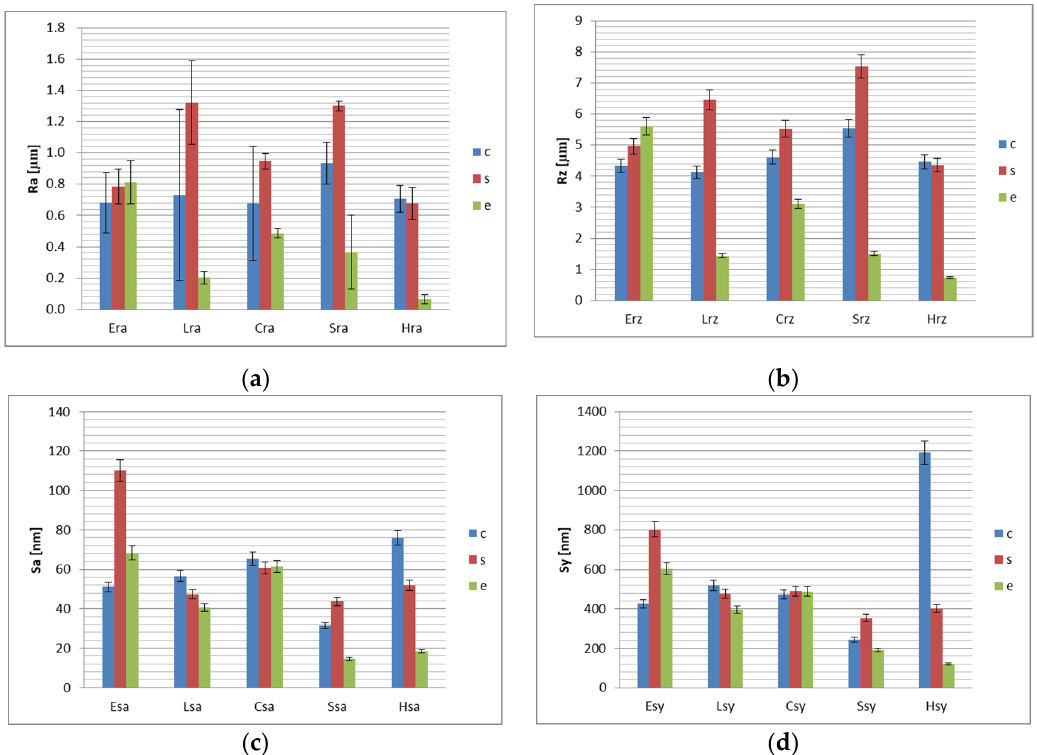
Figure 1. Surface roughness values of the samples, related to the conditioning method.( a ) R a (average surface roughness) for the conditioned resin-composite material samples, ( b ) R z values (maximum surface roughness) for the conditioned resin-composite samples, ( c ) S a (average nanoroughness) for the conditioned resin-composite samples, ( d ) S y (amplitude of heights) for the conditioned resin-composite samples.